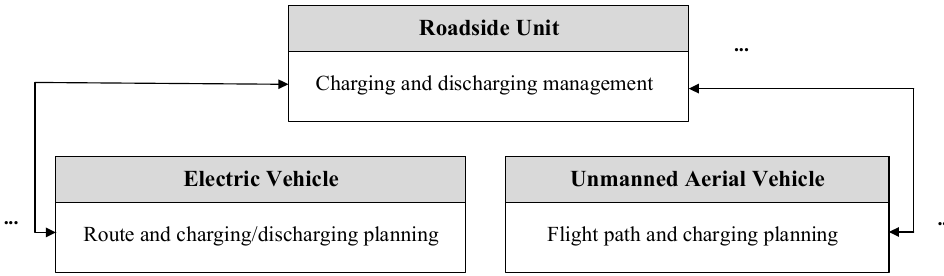
Figure 2. Framework of path routing and charging/discharging planning for EVs and UAVs.